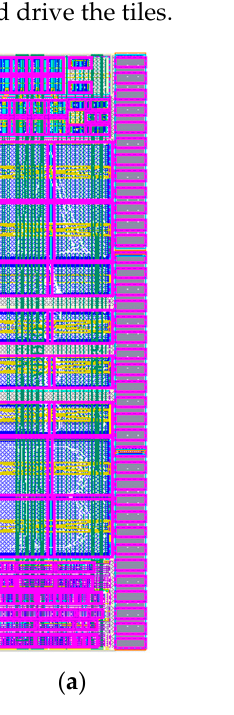
Figure 13. Proposed converter vs. conventional converter.